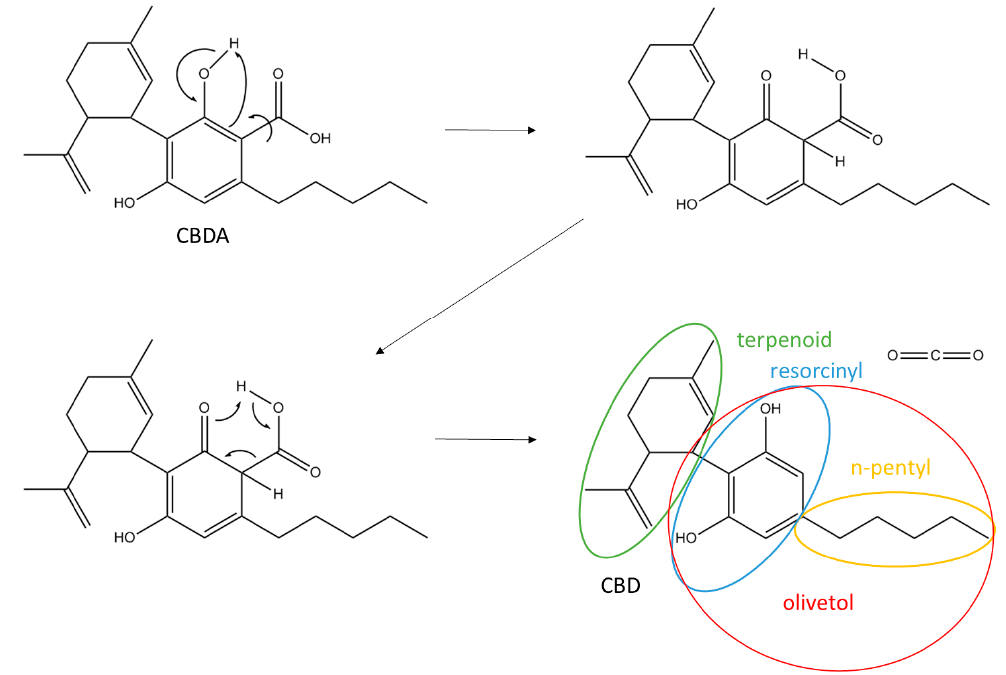
Figure1. Chemicalstructureofcannabidiolicacid(CBDA)withadecarboxylationschemeofcannabidiol Figure 1. Chemical structure of cannabidiolic acid (CBDA) with a decarboxylation scheme of cannabidiol (CBD).